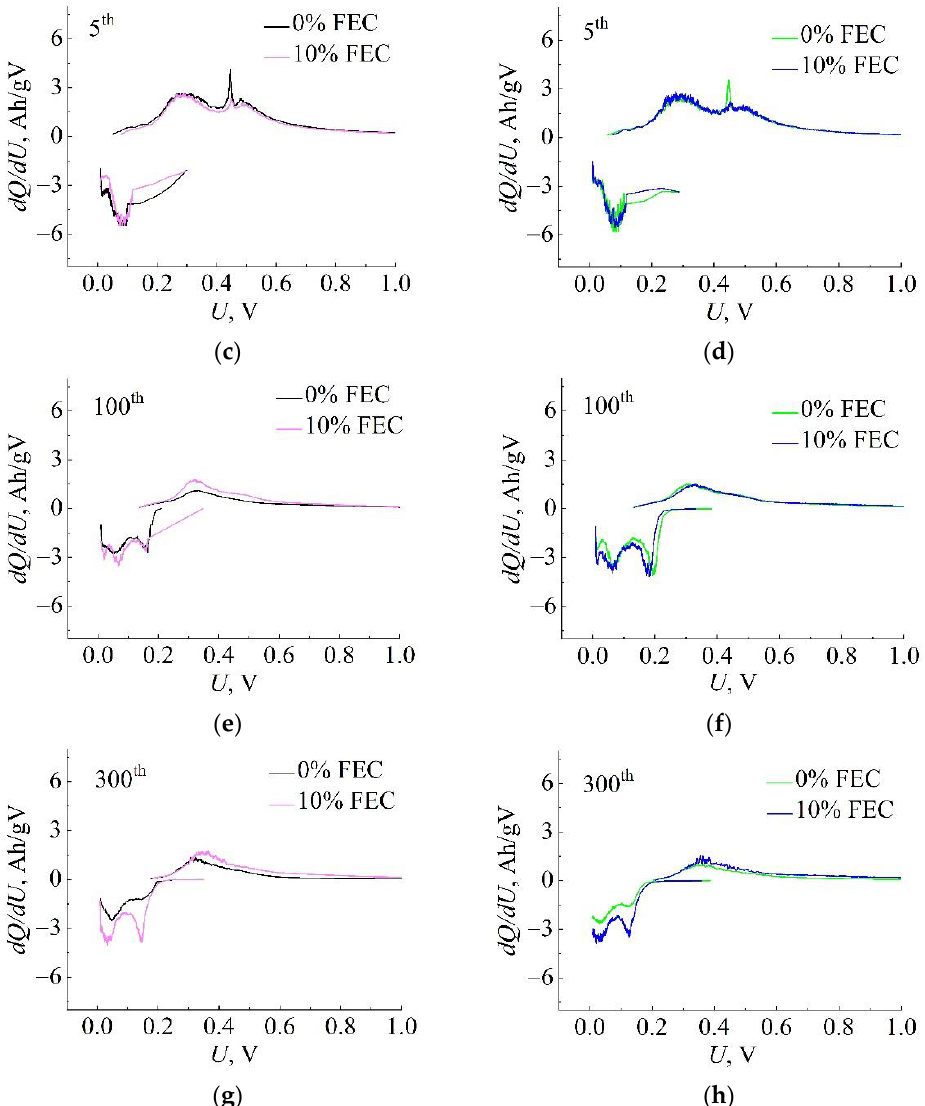
Batteries 2022 , 8 , x FOR PEER REVIEW Figure 5. Differential capacity (dQ/dU) plots of Si/C electrodes at different cycle number. The left column compares the samples of pair A ( a , c , e , g ), and the right compares pair B ( b , d , f , h ).